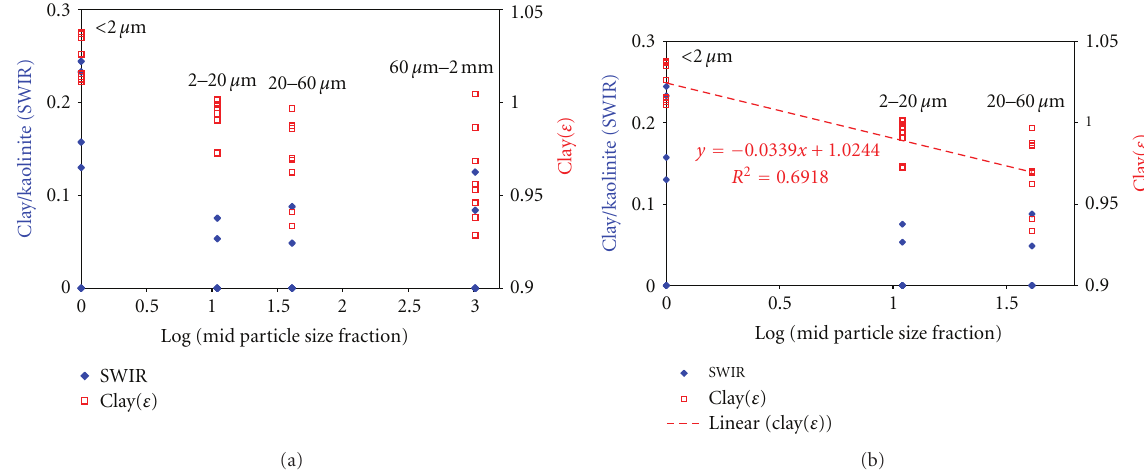
Figure 9: (a) Comparison of clay mineral content determined by SWIR defined clay/kaolinite spectral index and TIR defined Clay( ε ) for the four Tick Hill particle size fractions. (b) Close up of (a) and line of best fit for Clay( ε ) results for finest three particle size fractions.